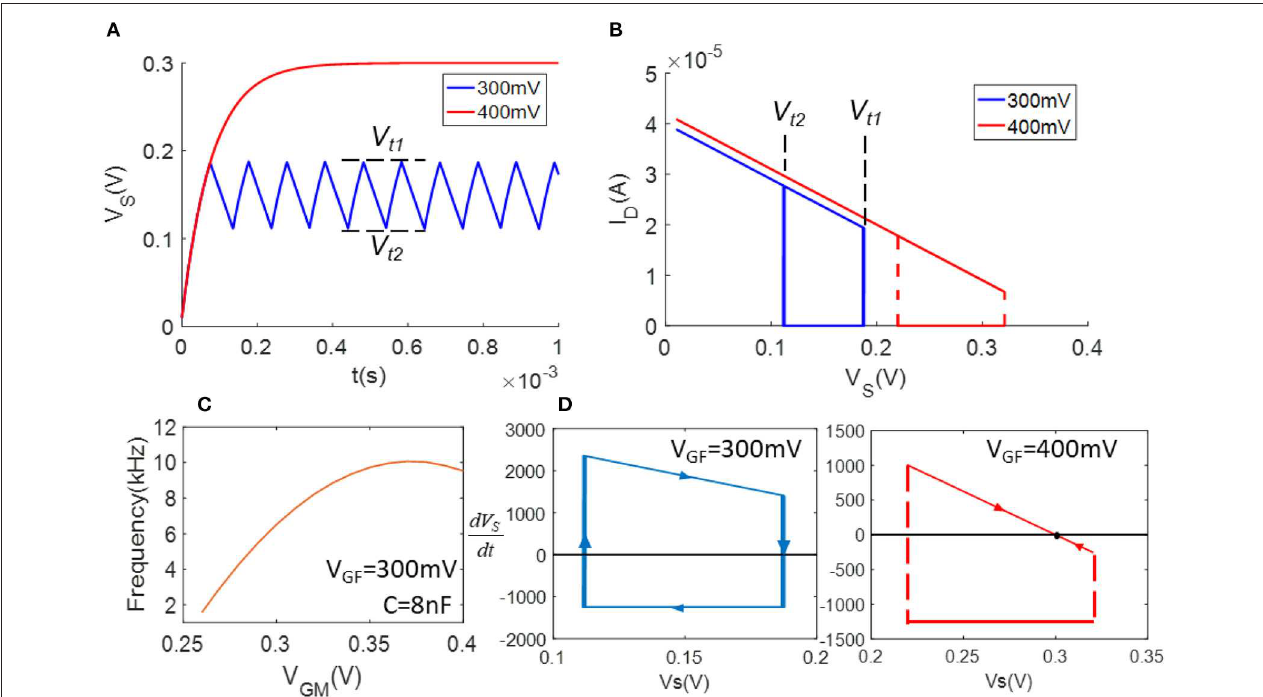
FIGURE 2 | Demonstration of model simulation: (A) waveforms of V S ( V GF = 300mV and 400mV); (B) I D – V S plot shows the hysteresis loops of I D in (A) ; (C) V GM v.s. frequency as V GF = 300mV; (D) flow diagrams of